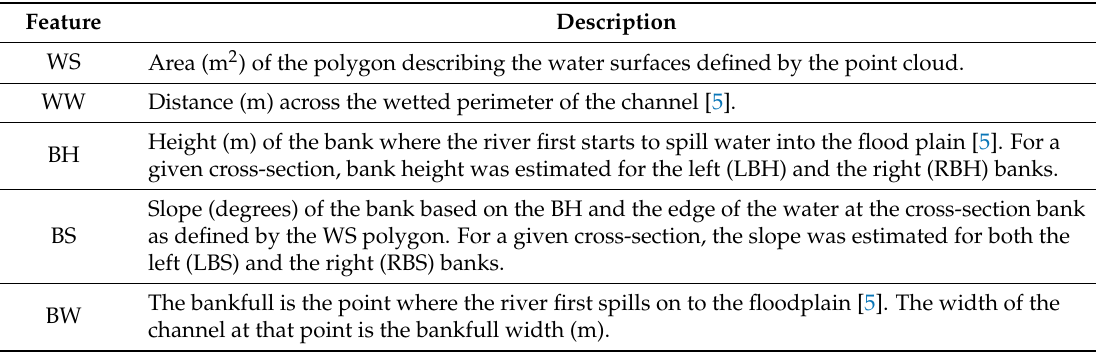
Figure 1. Location of the experimental setting at: ( a ) the Chicheley Brook (≈2 m wide), where downstream flow direction travels from the image horizon towards the camera lens; ( b ) the River Ouzel (≈8 m wide), where downstream flow direction travels from the camera lens towards the image horizon; and ( c ) the River Great Ouse (≈15 m wide), where downstream flow direction travels from the camera lens towards the image horizon. The images of the river sites depict part of the experimental setting along each of the reaches. Table 1. Hydromorphological measures estimated from the modelled river environment. Adapted from [5]. WS, WW, BH, BS and BW stand for water surface area, wetted water width, bank height, bank slope and bankfull width, respectively.